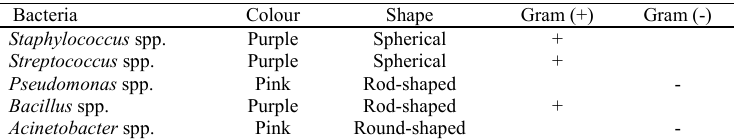
Table 6: Results for microbial characterization Bacteria Rod-shaped Rod-shaped Pink Round-shaped